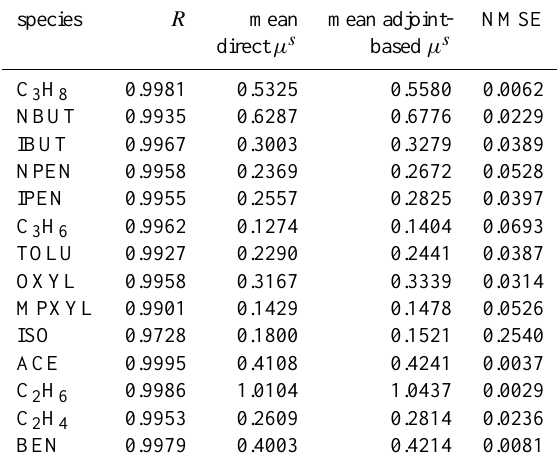
Table 4. Statistics of the discrepancy between the values of the observations as generated by the forward model, or generated with the approximate adjoint model: Pearson correlation ( R ), mean di- rect value, mean adjoint-based value and normalised mean square error (NMSE). The mean values are in µgm − 3 .